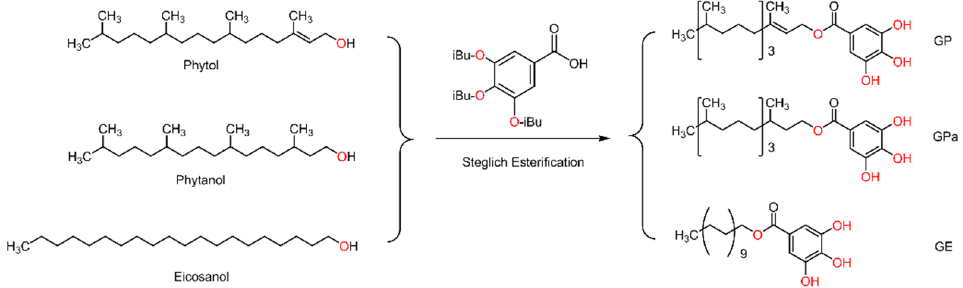
Figure 1. Synthetic route of galloyl phytol (GP), galloyl phytanol (GPa), and galloyl eicosanol